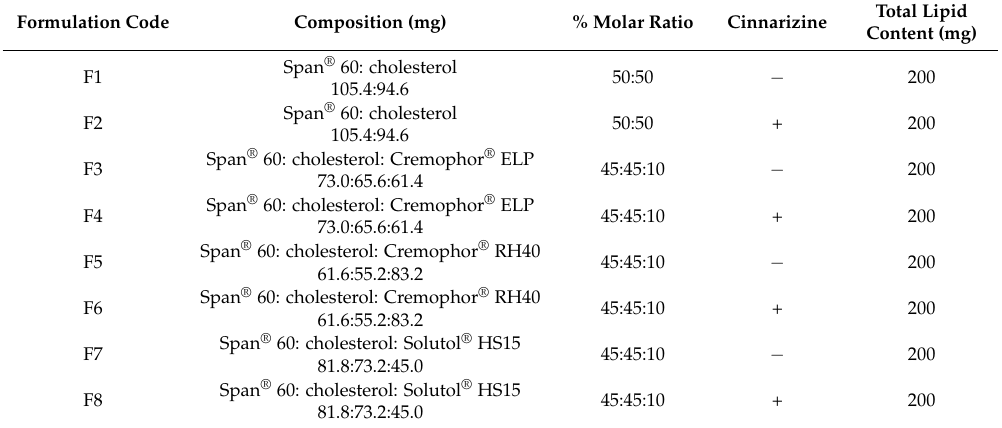
Table 1. Compositions of niosomal formulations (initial total lipid content of 10 mg/mL and initial drug content of 0.5